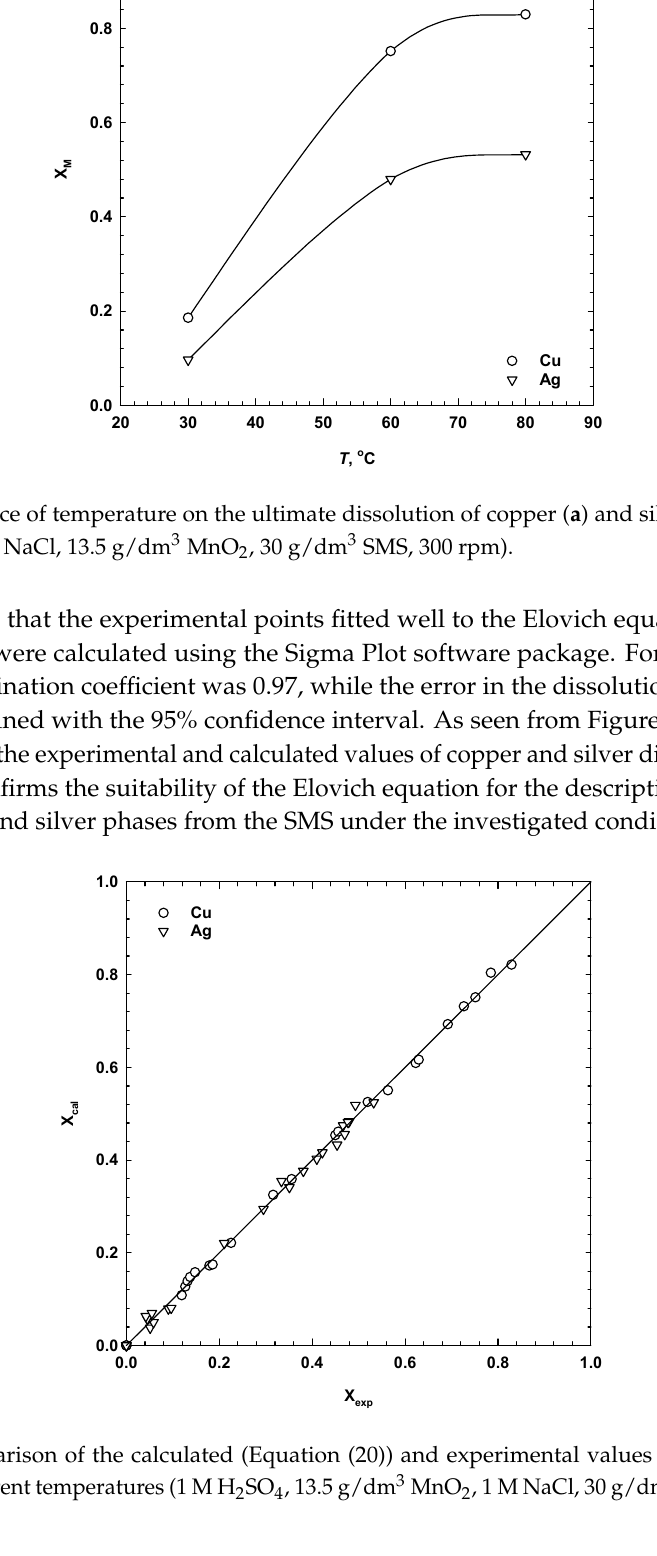
Figure 6. Effect of temperature on the dissolution of copper ( a ) and silver ( b ) (1 M H 2 SO 4 , 1 M NaCl,